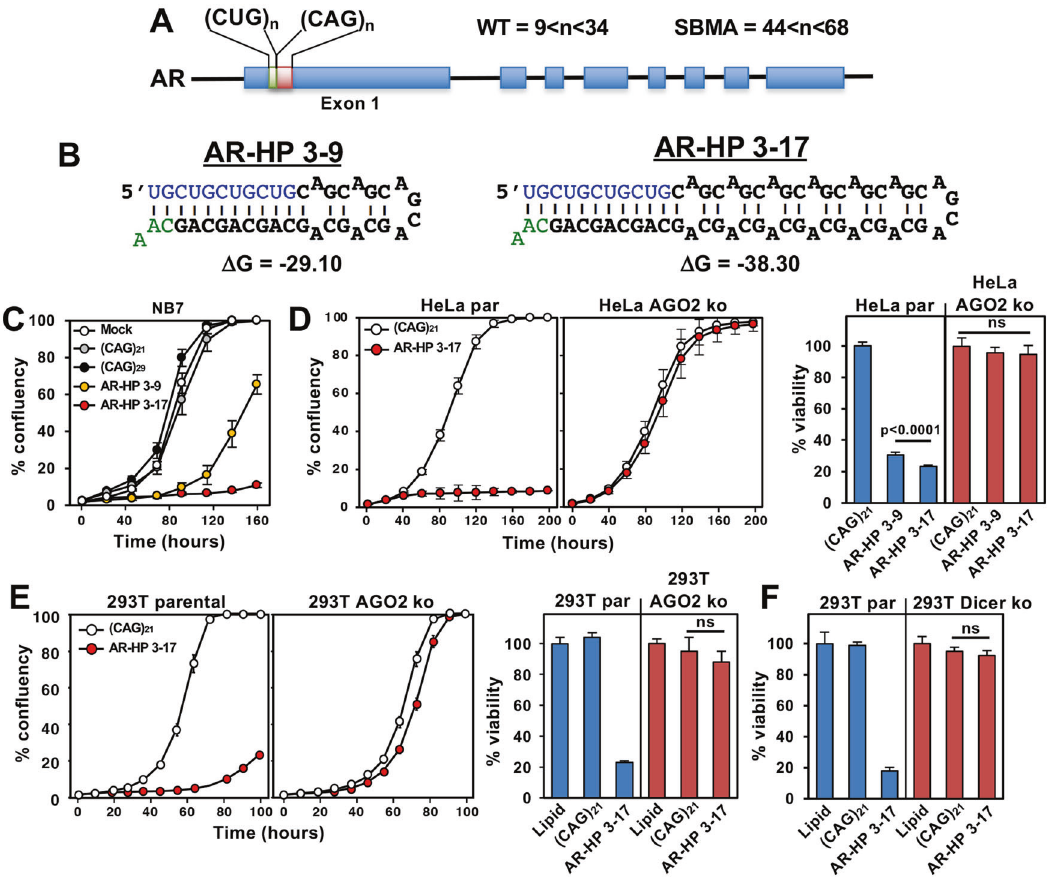
Fig. 4 An AR CAG TNR based HP with longer CAG repeats more effectively kills cells through RNAi. A Location of the CAG repeat region in the AR gene. The mean length of the CAG repeat in the AR gene in different SBMA patient populations ranges between 44 and 48. The maximum repeat length is around 68, whereas the normal length is between 9 and 34 [3, 17, 75]. B Structure of the HP mimetics used. Δ G value (in kcal/mol) is given. C , D , left panel , change in con fl uency over time of NB7, HeLa parental or HeLa AGO2 k.o. cells transfected with 2.5 nM (for NB7 cells) or 10 nM (for HeLa cells) of different HPs. D , right panel, viability of indicated cells 4 days after transfection with different HPs (10 nM). Fold change is shown relative to (CAG) 21 control. E , left panel , change in con fl uency over time of 293T parental or AGO2 k.o. cells transfected with 25 nM of either (CAG) 21 or 3 – 17. E , right panel , F , viability of indicated cells 3 days ( E ) or 4 days ( F ) after transfection with 25 nM ( E ) or 10 nM ( F ) of either (CAG) 21 or 3 – 17. Fold change is shown relative to lipid control. p = values (Student ’ s t -test) are shown ( D , right panel, E , right panel, F ). Average of 3-6 replicates are shown − / + SE ( C , D , left panel, E , left panel) and mean of 3 – 6 replicates are shown − / + SD ( D , right panel, E libraries: one derived from 10 pmol of two RNA size markers (19 and 35 nt, as nonrepetitive controls) and one that contained the same amount of two CAG TNR containing short RNAs (21 and 36 nt in length). We chose the 21 nt long CAG TNR sequence (CAG) 7 as this is the length of short CAG repeat containing RNAs (sCAGs) that was shown to be associated with disease pathology in HD patients [34]. In set 2 we fi rst mixed all four oligonucleotides and then sequenced the resulting library (Fig. 5A). This way CAG TNR containing oligonucleotides were in competition with the nonrepetitive size markers during all steps of library generation and sequencing. In none of the experiments were the larger oligonucleotides ef fi ciently sequenced in this small RNA seq experiment. In set 1 (CAG) 7 was more ef fi ciently sequenced than the 19 nt marker. However, sequencing errors of (CAG) 7 were much higher than seen with the control. Only 63% of all reads had the expected sequence and length (Fig. 5B, left). In set 2 sequencing of (CAG) 7 was less ef fi cient than that of the 19 nt marker suggesting that the CAG TNR-containing oligonucleotide was at a disadvantage compared to the nonrepetitive sequence (Fig. 5B, right). However, the results also suggested that it was possible to sequence sCAGs when they were present at high concentration.